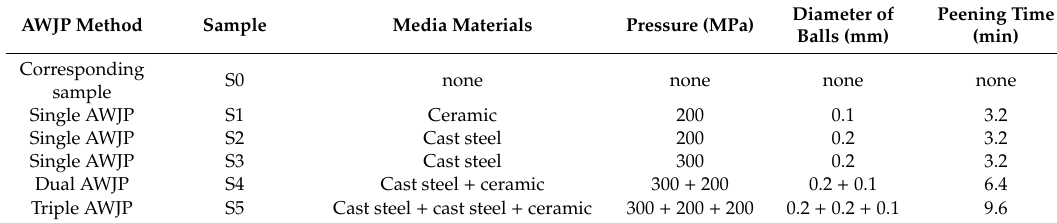
Table 3. Detailed parameters of multiple AWJP processes.